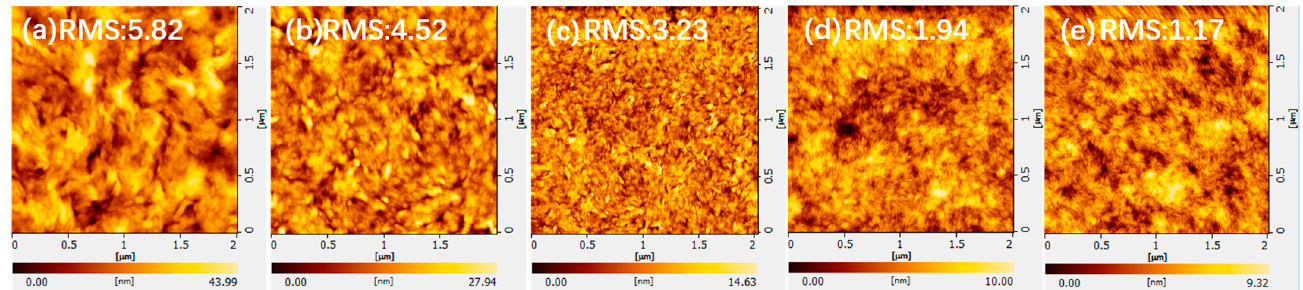
Figure 4. Surface morphology of active layers with di ff erent D: A ratios ( a ) 0.2:1.2; ( b ) 0.4:1.2; ( c ) 0.6:1.2; ( d ) 0.8:1.2; ( e ) 1.0:1.2.